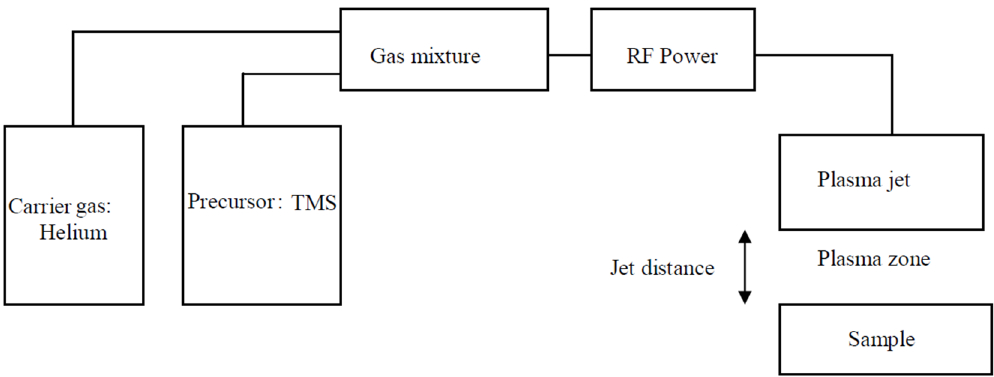
Figure 1. Schematic diagram of APP treatment.